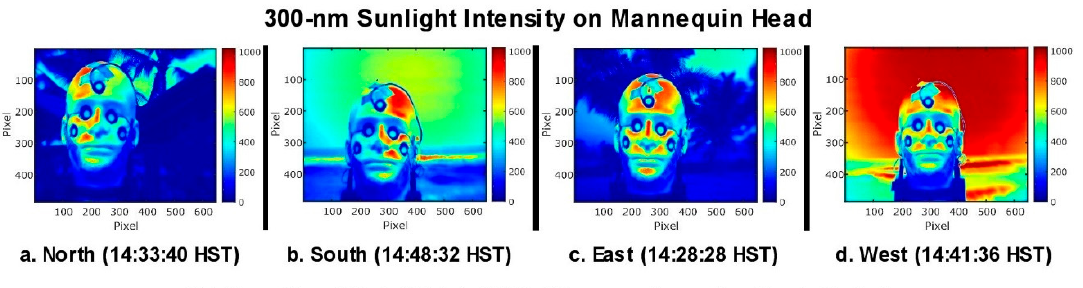
here to illustrate their potential merit.